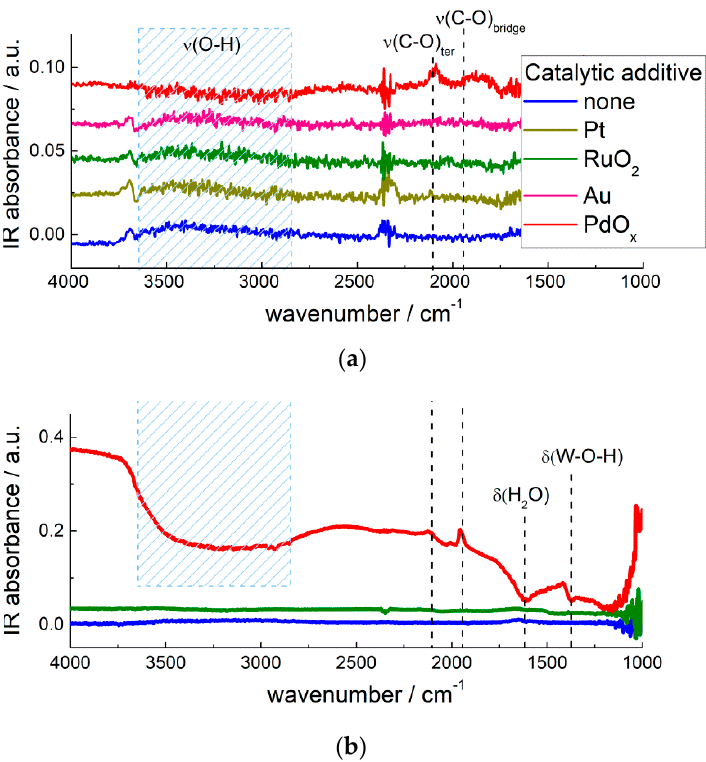
Figure 23. DRIFT spectra of pristine and functionalized by noble metal additives nanocrystalline SnO 2 ( a ) and WO 3 ( b ) exposed to CO (100 ppm ( a ); 200 ppm ( b )) at room temperature for 1 h. Adapted with permissions from ref. [75] copyright 2018 Elsevier; ref. [118] copyright 2015 American Chemical Society.